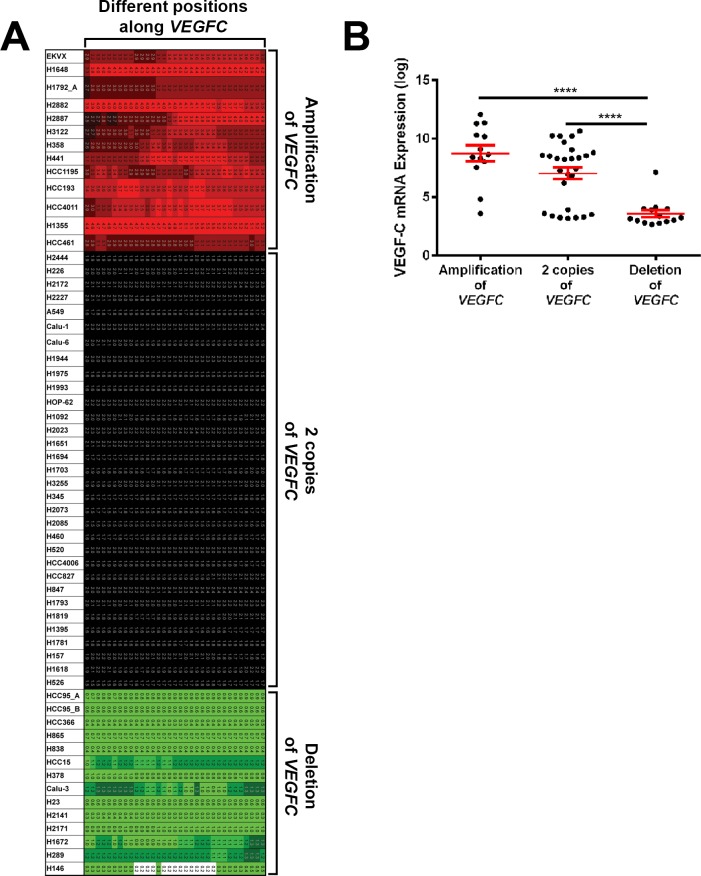
VEGF-C copy number variation influences VEGF-C expression.(A) Image showing VEGFC copy number variation for different lung cancer cell lines. Rows show data for individual lung cancer cell lines. Columns mark different positions along the VEGFC gene. Amplified positions are colored red, diploid positions are colored black, and deleted regions are colored green or white. (B) Graph showing log transformed VEGF-C mRNA levels from microarray data for cell lines that have more than 2 copies (range is between 3–5 copies of VEGFC), 2 copies, or less than 2 copies of the VEGFC gene. Graph shows mean ± SEM. **** P < 0.0001